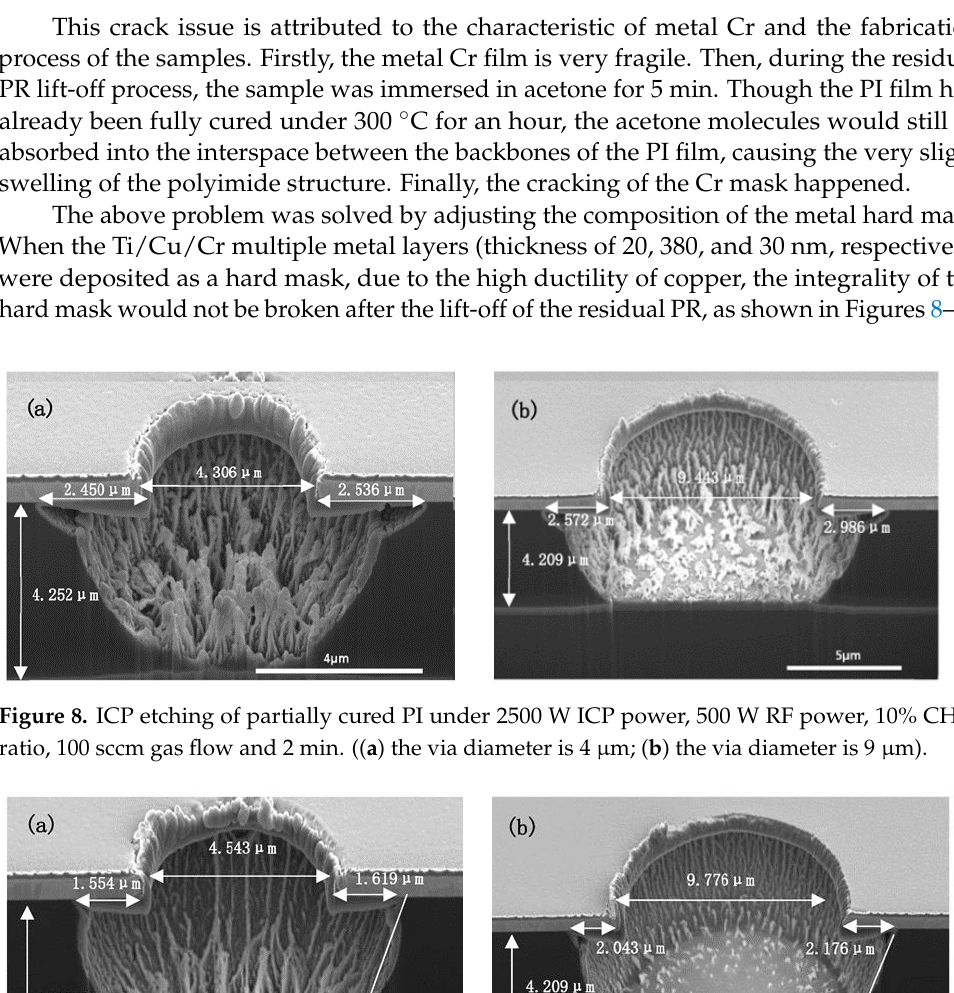
Figure 7. ICP etching of fully cured PI under 2500 W ICP power, 500 W RF power, 7% CHF 3 ratio, 100 sccm gas flow, and 0.5 min.